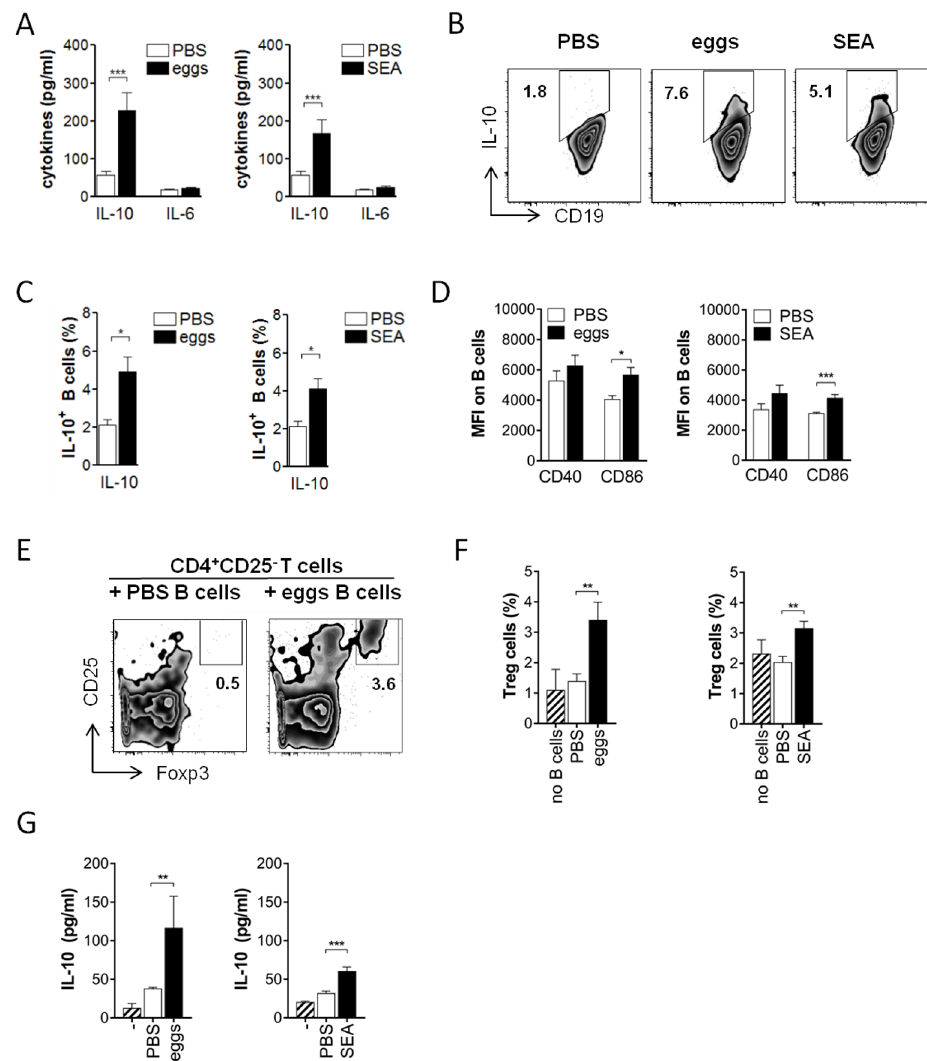
Fig 1. Schistosome eggs and SEA (soluble egg antigen) drive development of Breg cells in vivo . C57BL/6mice were i.p. injected with two doses of 5000 S . mansoni eggs or 100 μ g SEA in PBS, or PBS as control. At day 14, CD19 + MACS-isolated splenicB cells were restimulated with SEA (20 μ g/ml) for 2 days. (A) Cytokineconcentration in culture supernatants as determinedby ELISA. (B, C) Representative FACS plots (B) and summary (C) for intracellularIL-10 expressionof B cells after additionof BrefeldinA to the last 4 hours of the culture. (D) Mean fluorescence intensity of CD40and CD86 expression. (E-G) SEA-restimulated B cells were co-cultured for 4 days with CD25-depleted CD4 T cells. Frequency of CD25 + Foxp3 + Treg cells after co-culture in representative FACS plots (E) and summary (F) is shown. (G) IL-10 concentration in culture supernatants after co-culture. Summary of 4 experimentswith N = 12–16 (A-D) or 2 experiments with N = 8–9 (E-G). Significantdifferences by Mann-Whitney test are indicatedwith * p < 0.05, ** p < 0.01, *** p < 0.001.